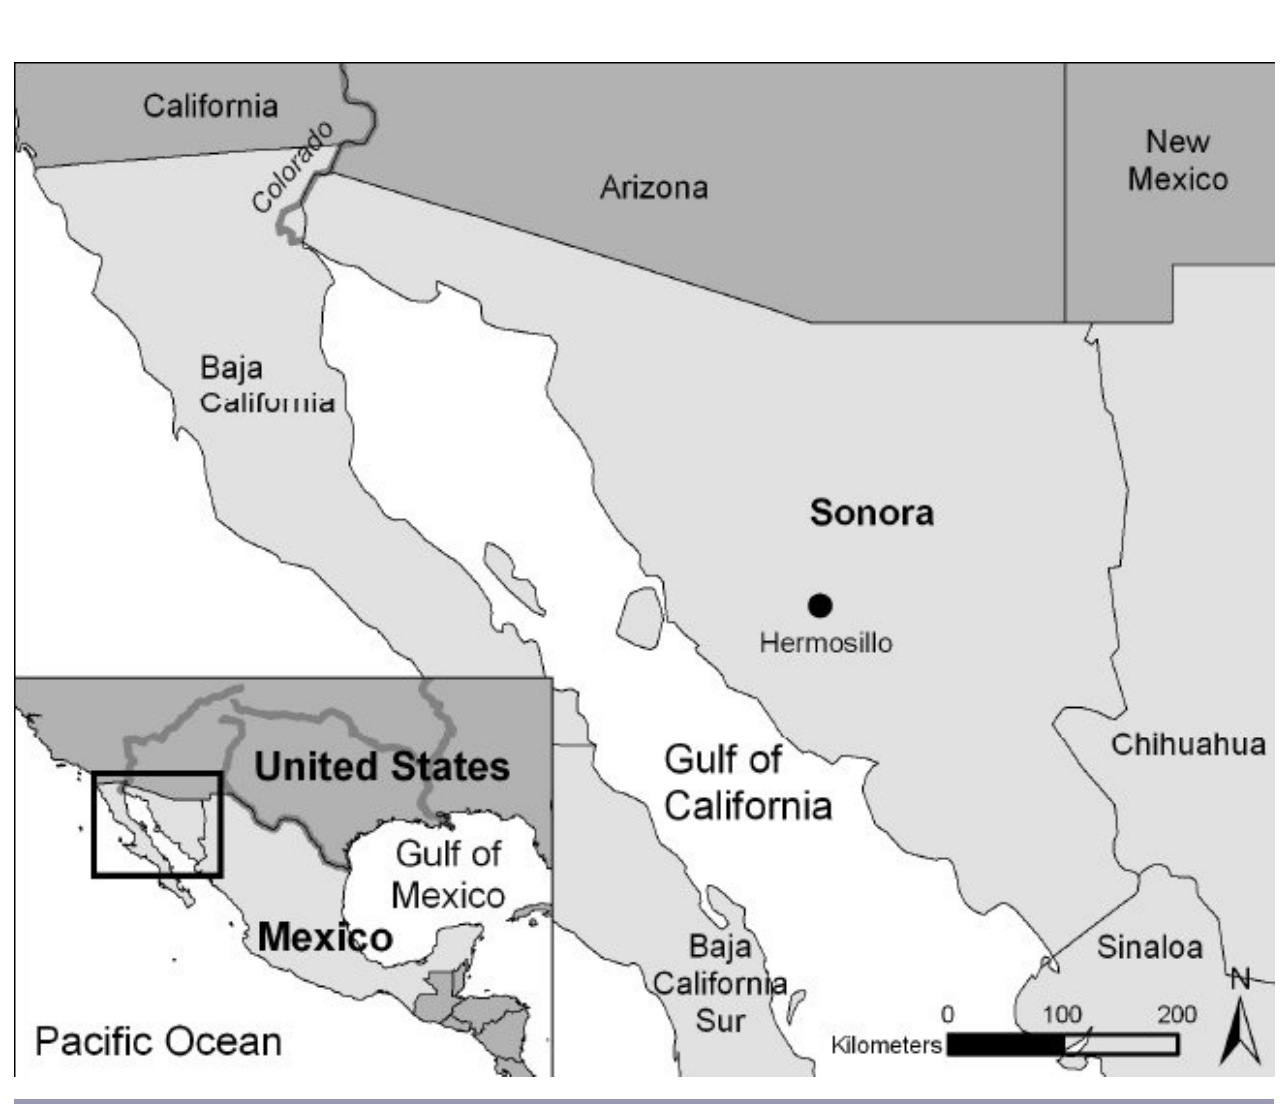
Fig. 1 . Research location: Sonora,